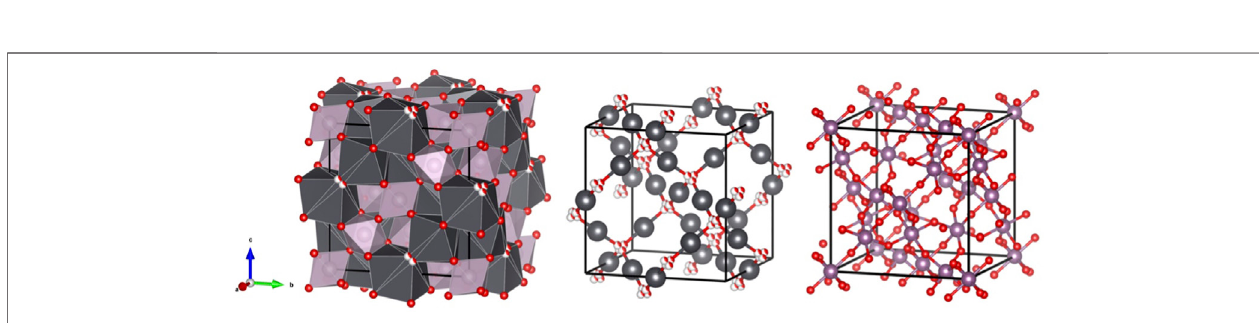
FIGURE 2| Interconnecting network and the twoseparate sub lattices, Pb sites are shown in grey, Tc sites in purple, O(1) as fully coloured (red) spheres, and O(2) are red and white spheres, indicating the four-fold disorder of these.